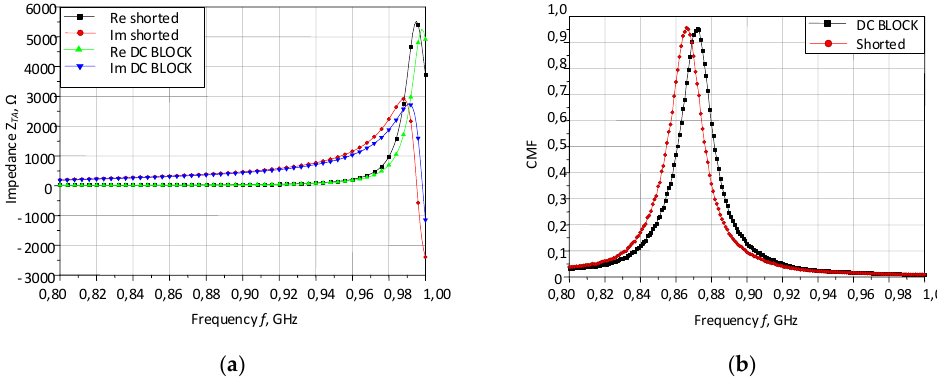
Figure 5. Preliminary simulation results of DC block impact. ( a ) Real and imaginary part of complex impedance. ( b ) CMF—conjugate match factor; DC BLOCK—antenna with matching circuit based on capacitor; shorted—antenna with short-circuited